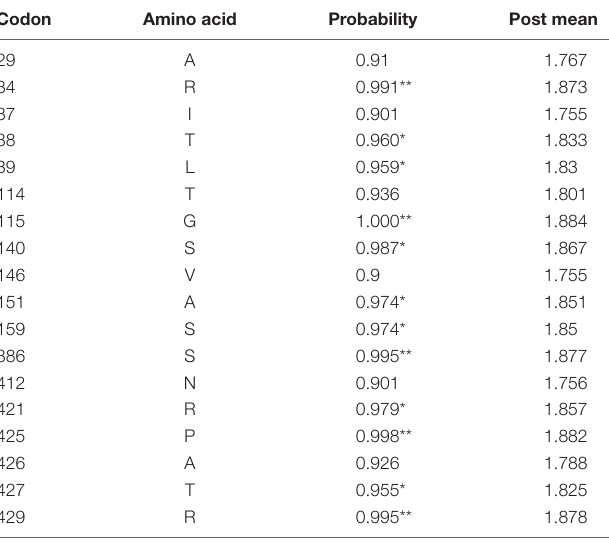
TABLE 6 | Positively selected sites in lacZ of Erwinia sp. E602 identified with site model M2a using Bayes Empirical Bayes